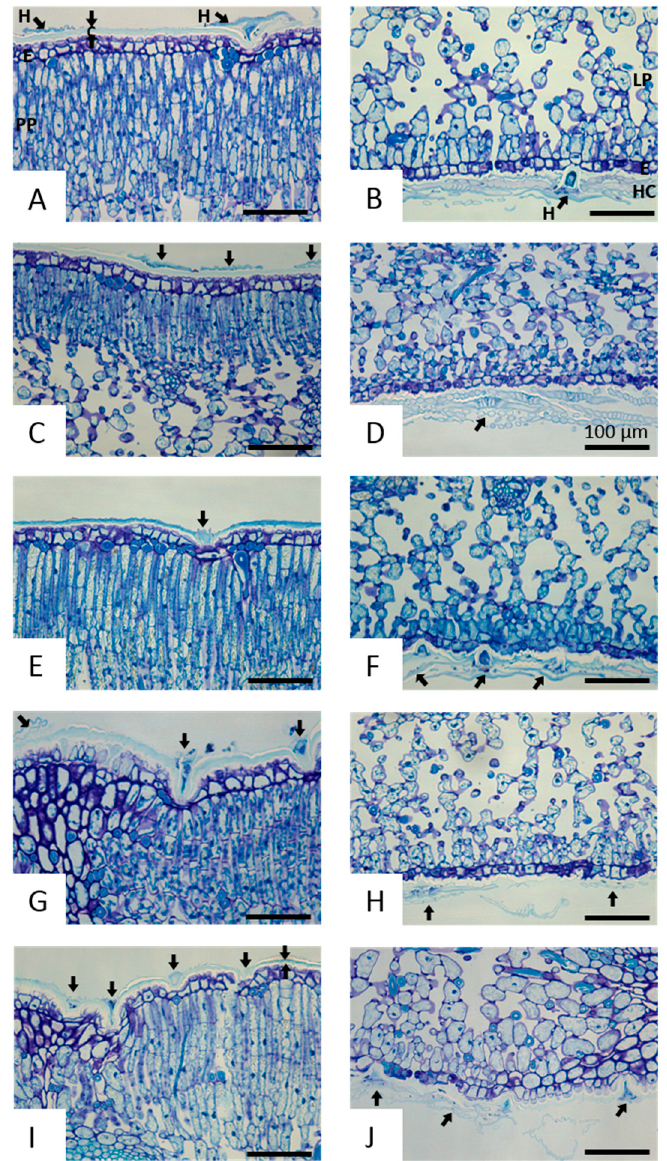
Figure 3. Comparison of olive leaf cross sections tainted in toluidine blue by optical microscopy for untreated leaf, control leaf (60 min stirring), and ultrasound-treated leaves (5 min, 15 min, and 60 min). Legend (Figure 3): Cuticle (C), Epidermis (E), Hair (H), Palisadic Parenchyma (PP), Lacunary Parenchyma (LP), Hair Layer (HC). All observations were made at a magnification of 20 × the original picture’s scale. Bars: 100 µ m. Non labeled arrows designate observations of leaf structures discussed in the result section. ( A , B ) Untreated olive leaf abaxial and adaxial side, respectively. ( C , D ) Control leaf, after 60 min of stirring at 20 ◦ C, abaxial and adaxial side, respectively. ( E , F ) Leaf treated with ultrasound for 5 min at 20 ◦ C, abaxial and adaxial side, respectively. ( G , H ) Leaf treated with ultrasound for 15 min at 20 ◦ C, abaxial and adaxial side, respectively. ( I , J ) Leaf treated with ultrasound for 60 min at 20 °C, abaxial and adaxial side, respectively.